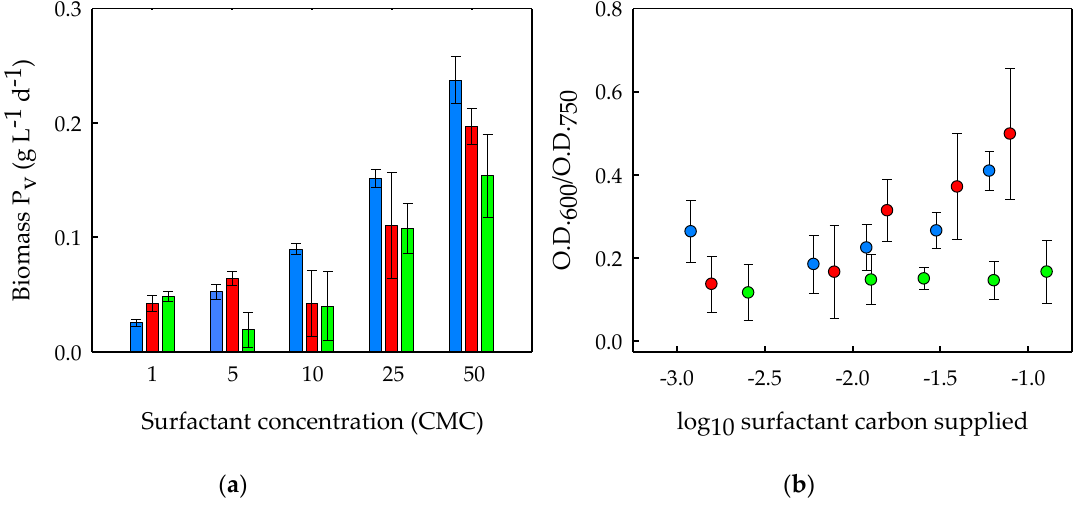
Figure 3. ( a ) Volumetric biomass productivity of Scenedesmus obliquus (Biomass Pv), expressed as grams of biomass produced per liter of culture broth and per day, and ( b ) bacteria-to-microalgae ratio, expressed as the ratio between the optical density at 600 nm and that at 750 nm after 2.8 days of cultivation (O.D. 600 / O.D. 750 ) in cultures enriched with BSA (blue bars and symbols), Saponin (red bars and symbols) and Tween 20 (green bars and symbols) at concentrations of 1, 5, 10, 25 and 50 CMC. The average values of duplicate cultures are shown, together with their corresponding standard deviations. Surfactant concentration is expressed in ( a ) CMC units and ( b ) as the carbon dosage resulting from surfactant addition (logarithmic values, in milligrams).